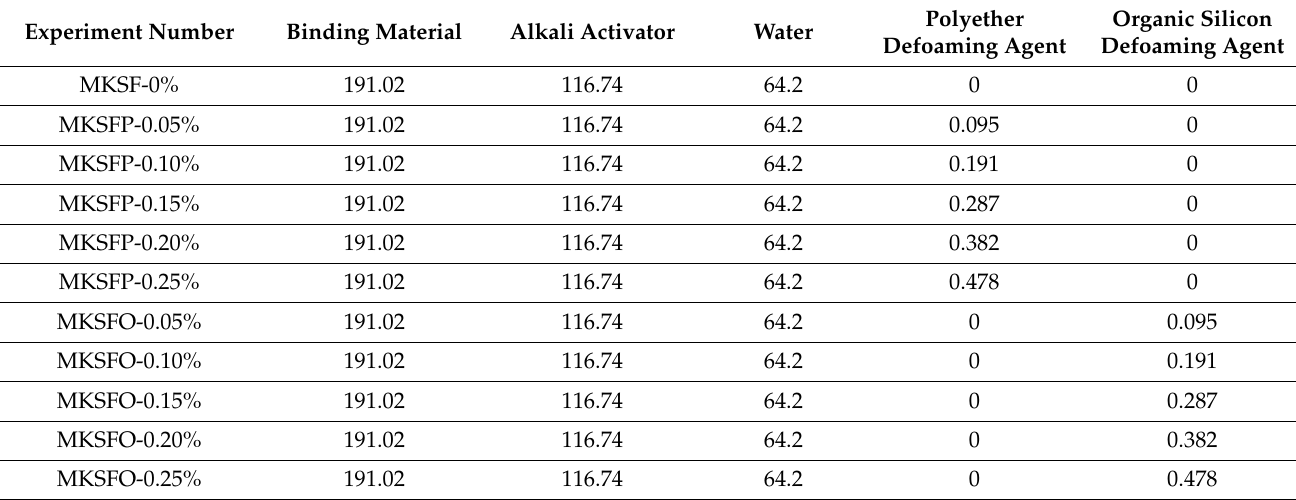
Figure 3. The flowchart of experiment methodology. Table 6. Mixture ratio of different defoamers and